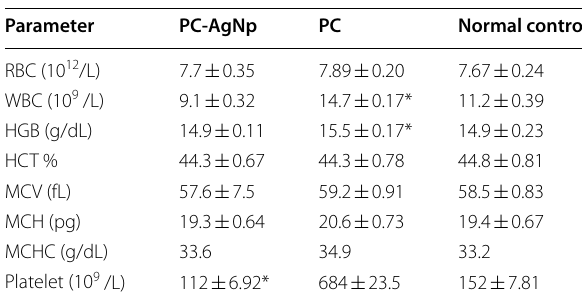
Table 2 Comparison of hematological parameters in different groups of rats comparison of hematological parameters in different groups of rats (control, PC consuming group and PC-AgNp consuming group)